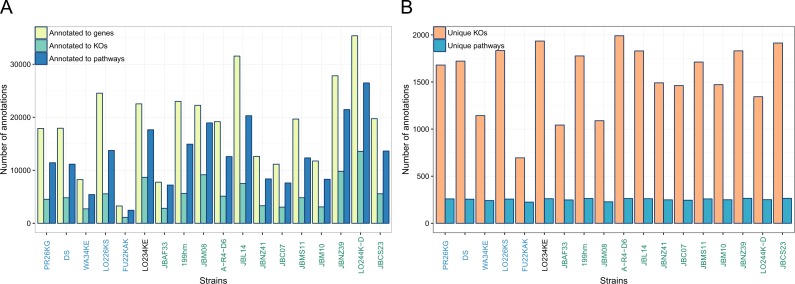
Number of annotations to KEGG genes, KEGG Orthology IDs (KOs) and to KEGG pathways from all transcripts of each sample (A) and the number of unique KOs and KEGG pathways for each sample (B).Strains on the x-axis are sorted and coloured according to Fig. 1.